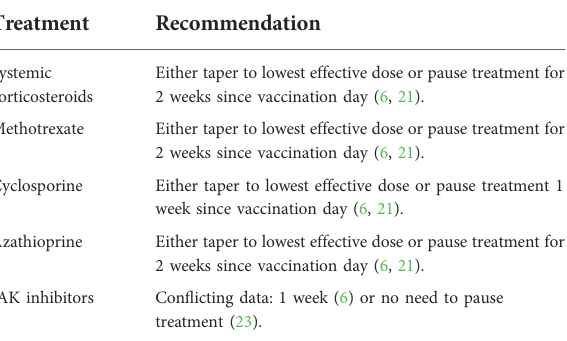
TABLE 2 Summary of current recommendation for SARS-CoV-2 vaccination in AD patients maintained on systemic therapy. Treatment Recommendation Systemic corticosteroids